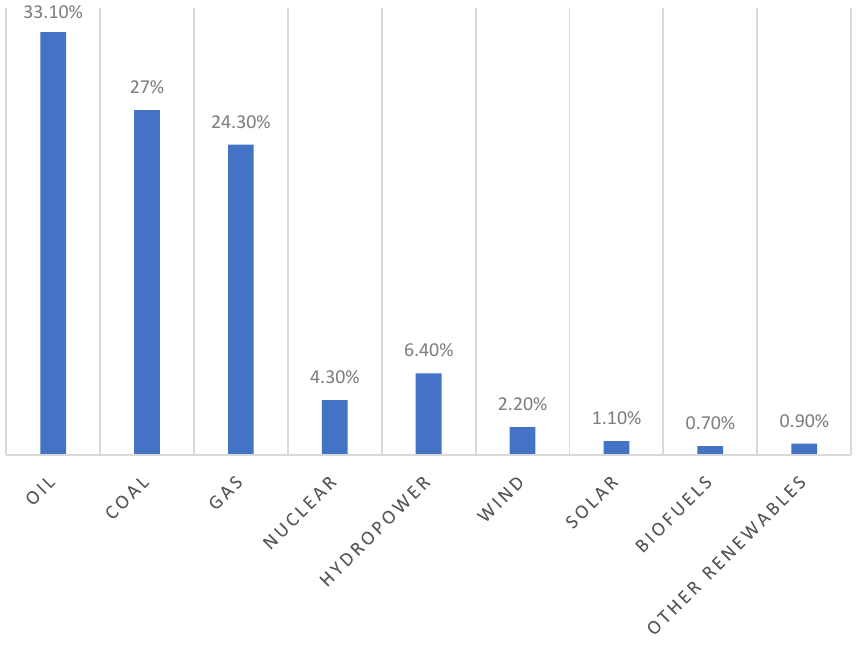
Figure 1. Global resource usage in 2019 [1]